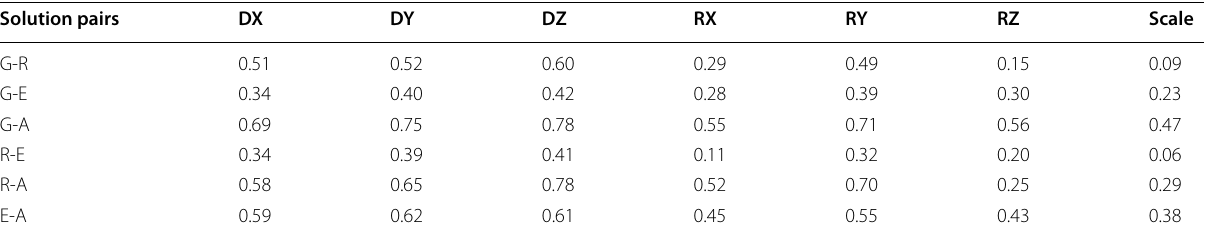
Table 4 Correlation coefficients for the transformation parameters derived from PPP using the combined orbits and clocks. ‘G’, ‘R’, ‘E’, and ‘A’ in the first column indicate the PPP results for the GPS, GLONASS, Galileo and multi-GNSS combined solutions, respectively Solution pairs DX G-R